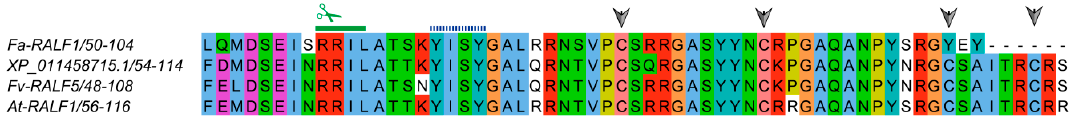
Figure 7. The alignment of three RALF genes similar to FaRALF-33-like.